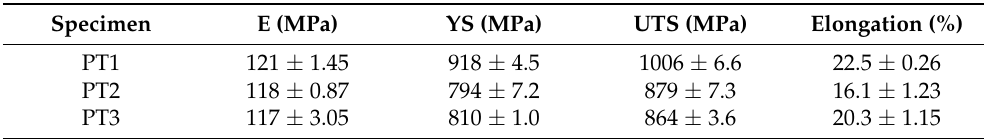
Figure 10. ( a ) Typical stress–strain curves and ( b ) static tensile properties of the PT1, PT2, and PT3 specimens. Table 3. Young’s modulus (E), yield strength (YS), ultimate tensile strength (UTS), and elongation at break after PT1, PT2, and